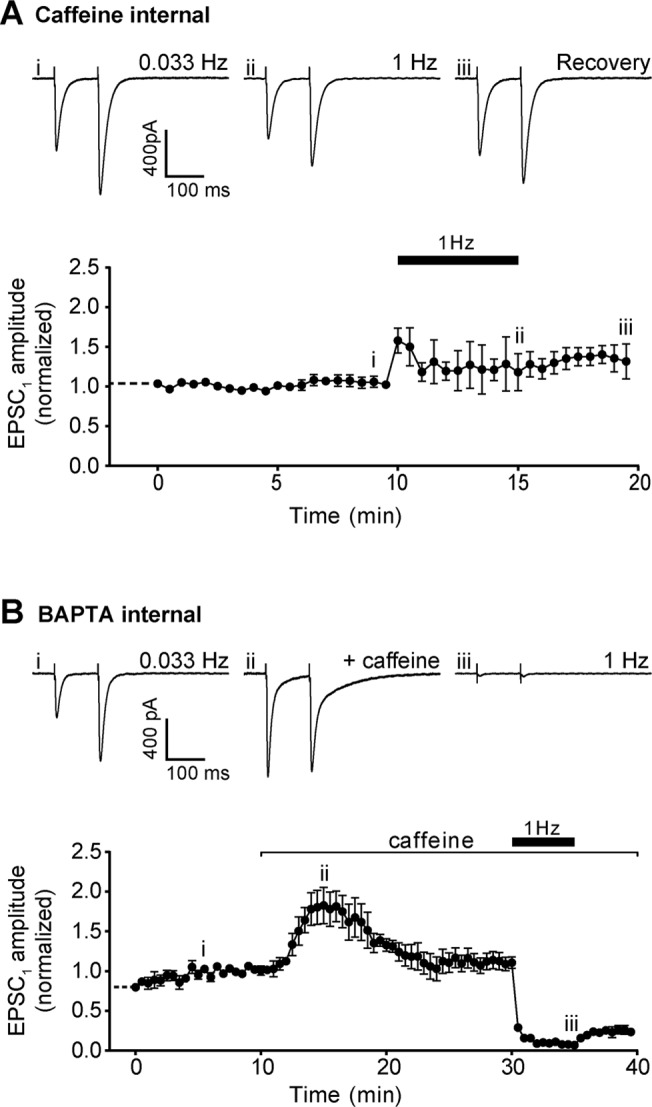
Caffeine response following modification of internal buffer solution.A) Representative recordings of Purkinje neuron EPSC with 15 mM caffeine in the internal pipette solution after 10 min of paired pulse stimulation at 0.033 Hz (upper left panel), after a further 5 min stimulation at 1 Hz (upper centre panel), and following a 5 min return to 0.033 Hz (upper right panel). Roman numerals refer to time points in 9A (lower panel). Lower panel shows time course of intracellular caffeine effect on Purkinje neuron EPSC1 amplitude. Dashed line prior to t = 0 indicates period immediately following breakthrough to whole-cell configuration, but prior to establishing stimulation conditions. Data are mean ± s.e.m. from 4 cells (1 animal). B) Representative recordings of Purkinje neuron EPSC with 30 mM BAPTA in the internal solution buffer under control conditions (upper left panel), following the addition of 50 mM caffeine (upper centre panel), and following 5 min of 1 Hz stimulation (upper right panel). Roman numerals refer to time points in 9B (lower panel). Lower panel shows time course of caffeine effect with intracellular BAPTA present on Purkinje neuron EPSC1 amplitude. Data are mean ± s.e.m. from 4 cells (2 animals).